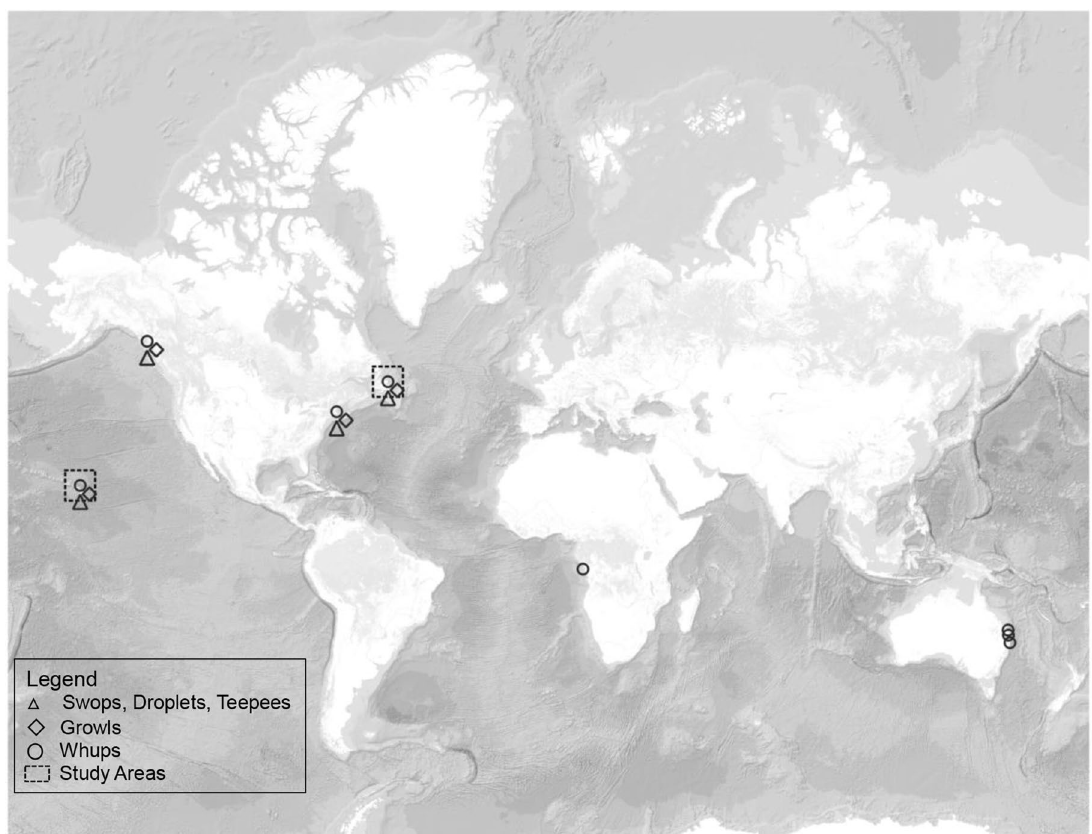
Figure 1. World map showing the locations of the two study areas (Newfoundland 86 and Hawaii 46 ) in boxes, along with other regions where one or more of the five call types have been described, representing two migration routes and two foraging grounds. From left to right on the map (excluding the study sites): Southeast Alaska, USA (foraging) where all five call types were identified and found to be stable over 36 years (1976–2012) 25,54,57 ; Massachusetts Bay, USA (foraging; 2008) 25 ; Angola, Africa (migration; 2012) 62 ; Harvey Bay and Byron Bay (1997, 2003, 2004, 2008), Australia (migration) where whups (called ‘wops’) were stable over 11 years 61 ; and other locations on the East Coast of Australia (migration; 2002–2004 56 ; 2002–2004, 2008 67 ). This map was created using QGIS 3.8.3-Zanzibar (https:// qgis. org/ en/ site/ forus ers/ downl oad. html) using the ESRI Ocean basemap (https:// servi ces. arcgi sonli ne. com/ ArcGIS/ rest/ servi ces/ Ocean/ World_ Ocean_ Base/ MapSe